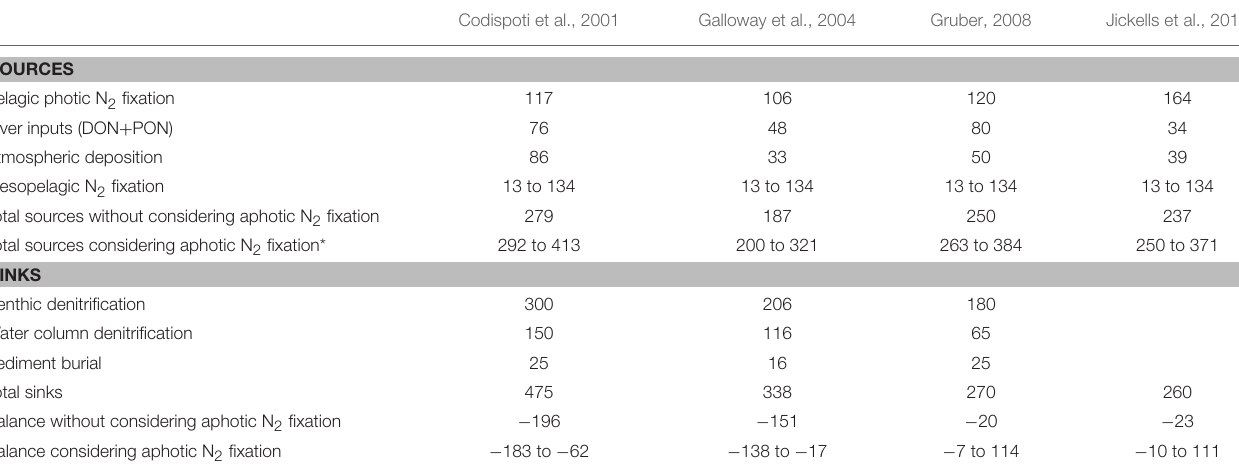
TABLE 1 | Global nitrogen budgets and their variability when considering aphotic N 2